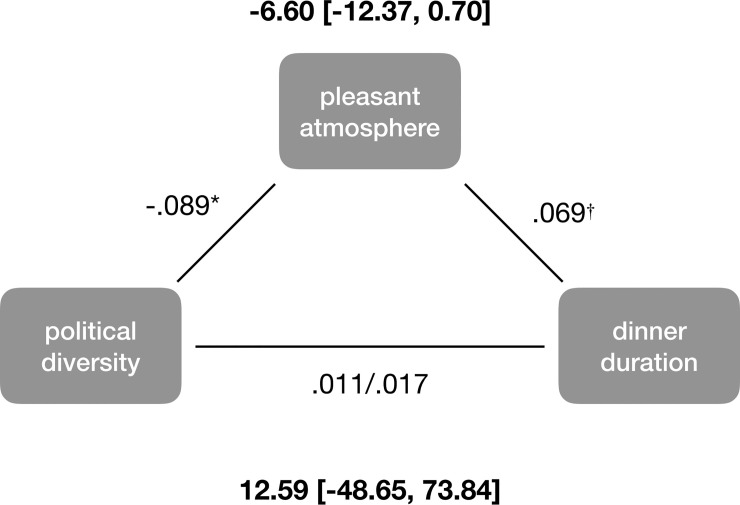
Mediation model assessing whether an unpleasant social atmosphere helped explain why political diversity is associated with shorter Thanksgiving dinners.Direct and indirect effects shown in boldface. † p < .10, * p < .05.